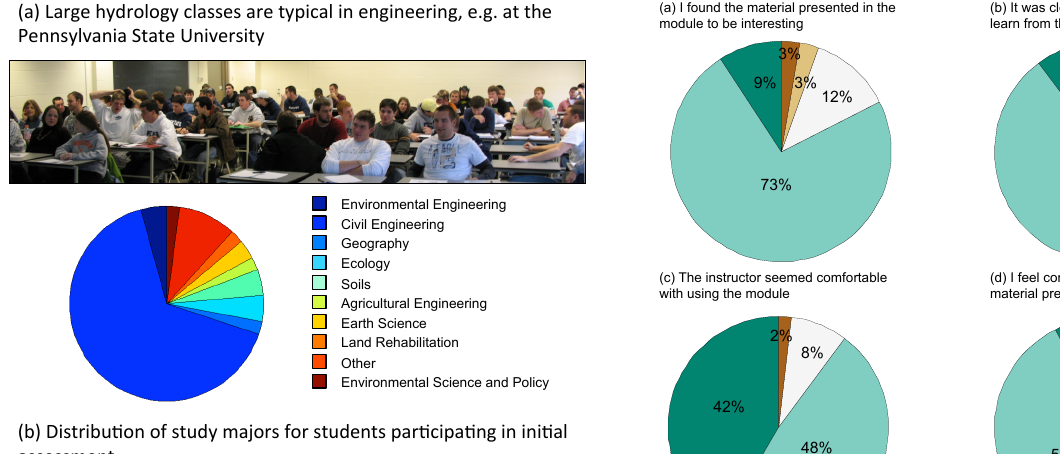
Fig. 3. Major disciplines for the 110 students included in the initial MOCHA module assessment.